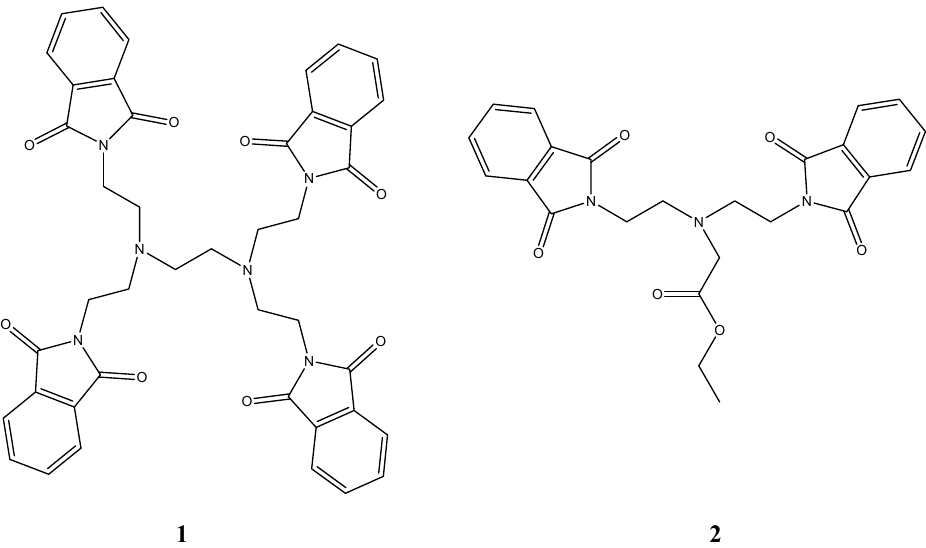
Figure 7. Structures of